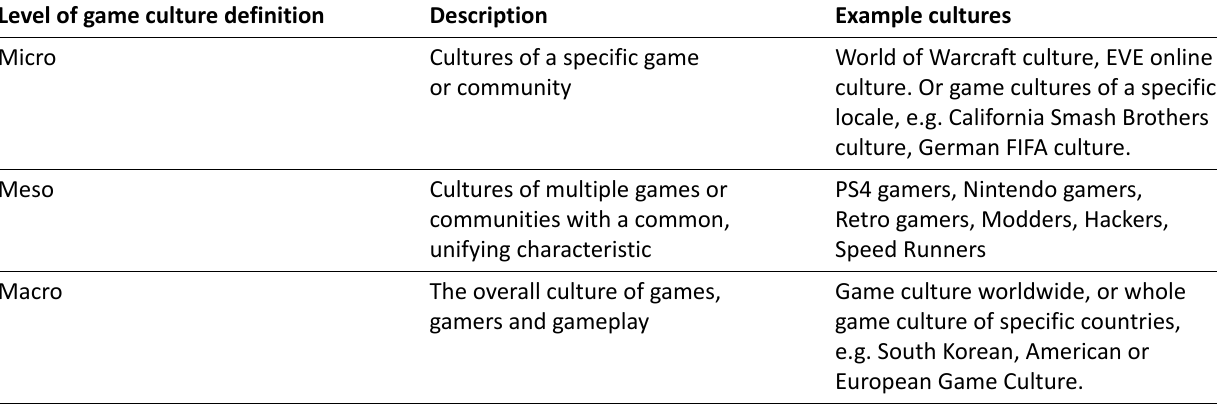
Table 1. Various levels of defining game